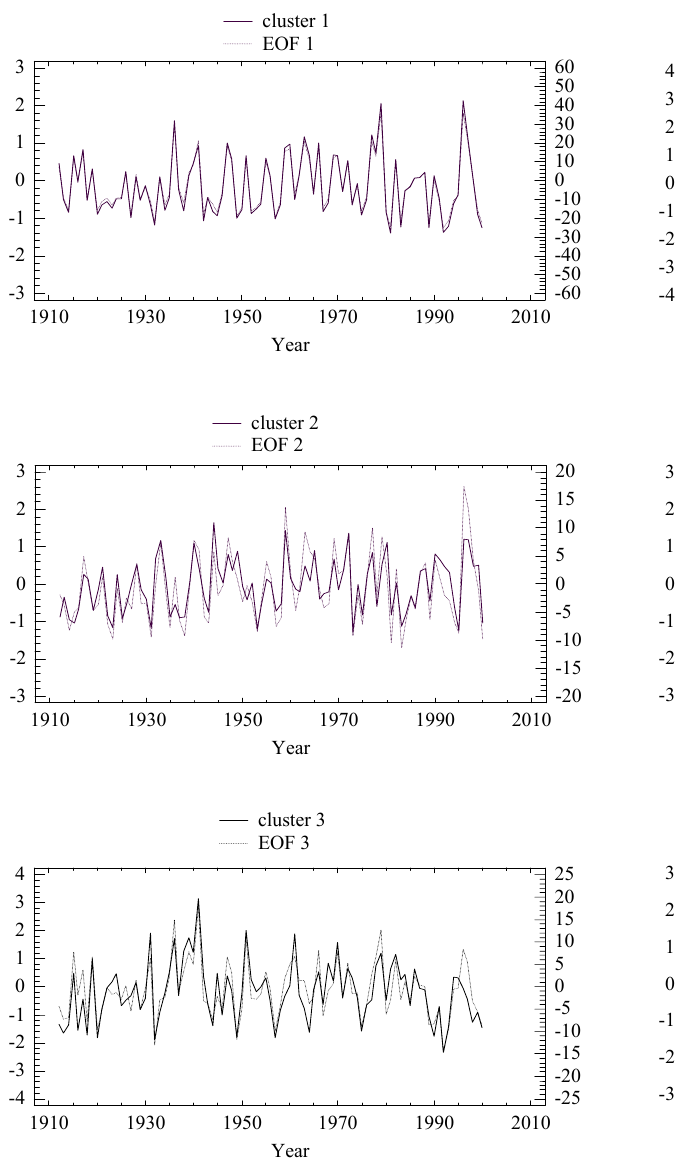
Fig. 11. As Fig. 10, for